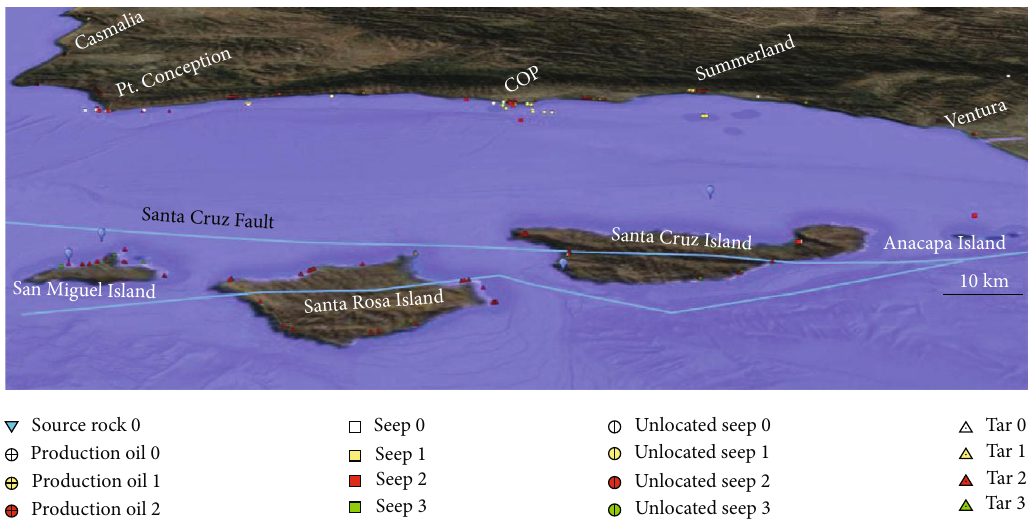
Figure 14: Visualization of major faults and location of seeps around the Channel Islands. Based on data in Fischer [50] and tar ball sample location from Lorenson et al. [125]. See data key for tar sample “ tribes ” or chemical grouping. Displayed in the Google Earth